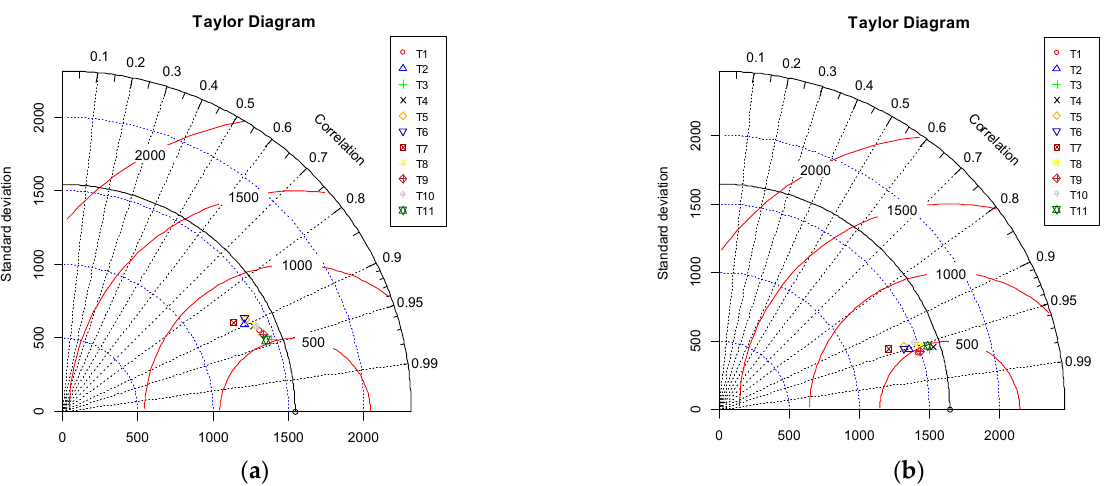
Figure 9. Taylor diagram for the proposed models. ( a ) Training phase, ( b ) Testing phase.